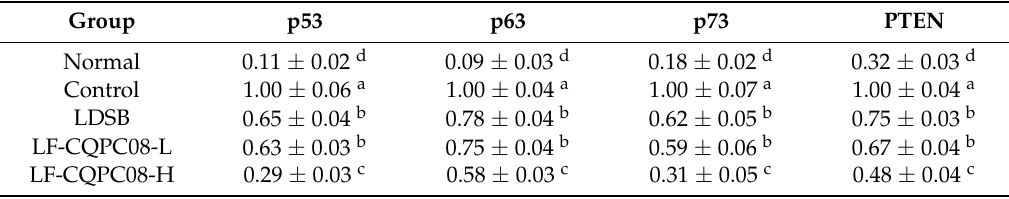
Table 7. p53, p63, p73 and PTEN mRNA expression in tongue tissue of mice (relative to multiple of control